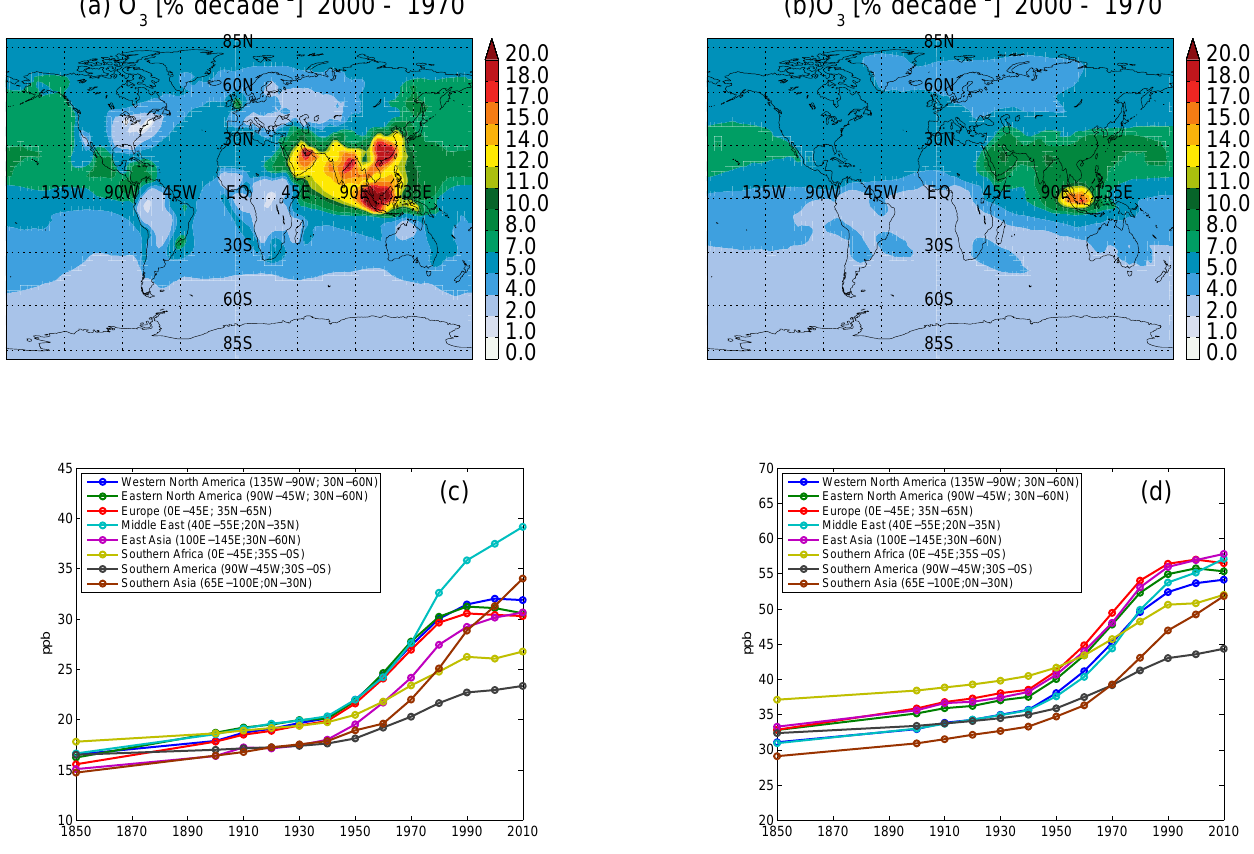
Fig. 6. Relative change from 1970 to 2000 (% decade − 1 ) in surface O 3 (a) and at approximately 500hPa (b) and time evolution of regional mean O 3 at the surface (c) and approximately 500hPa (d) .